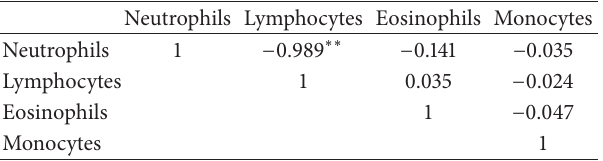
Figure 14: Showing mean value WBC of control and iron deficiency anaemia. Table 5: Showing correlation among hematologic variables in Iron deficiency anemia patients.